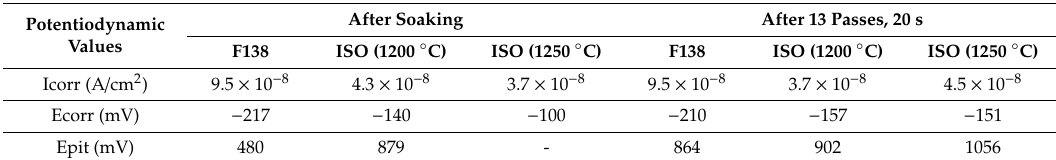
Figure 12. Representative potentiodynamic polarization curves ( a ) after soaking and ( b ) after deformation up to 13 passes. Nyquist plots of electrochemical impedance spectroscopy (EIS) ( c ) after soaking and ( d ) after deformation up to 13 passes. Soaking temperature conditions are annotated in the Figures. Tests were performed in the simulated body fluid (SBF) solution at 37 ◦ C. Table 2. Summary of values of corrosion current density (Icorr), corrosion potential (Ecorr), and pitting potential (Epit) taken from polarization